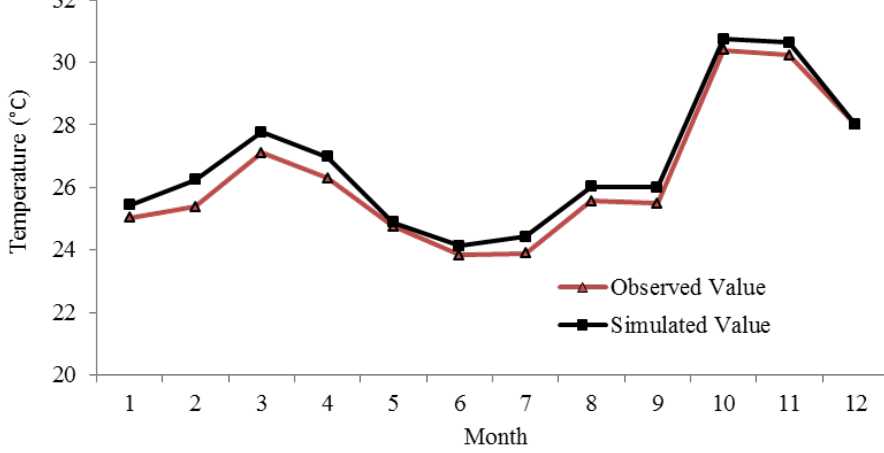
Figure A3. Simulated and observed values of the monthly average near-surface temperature of Brazilian Amazon in